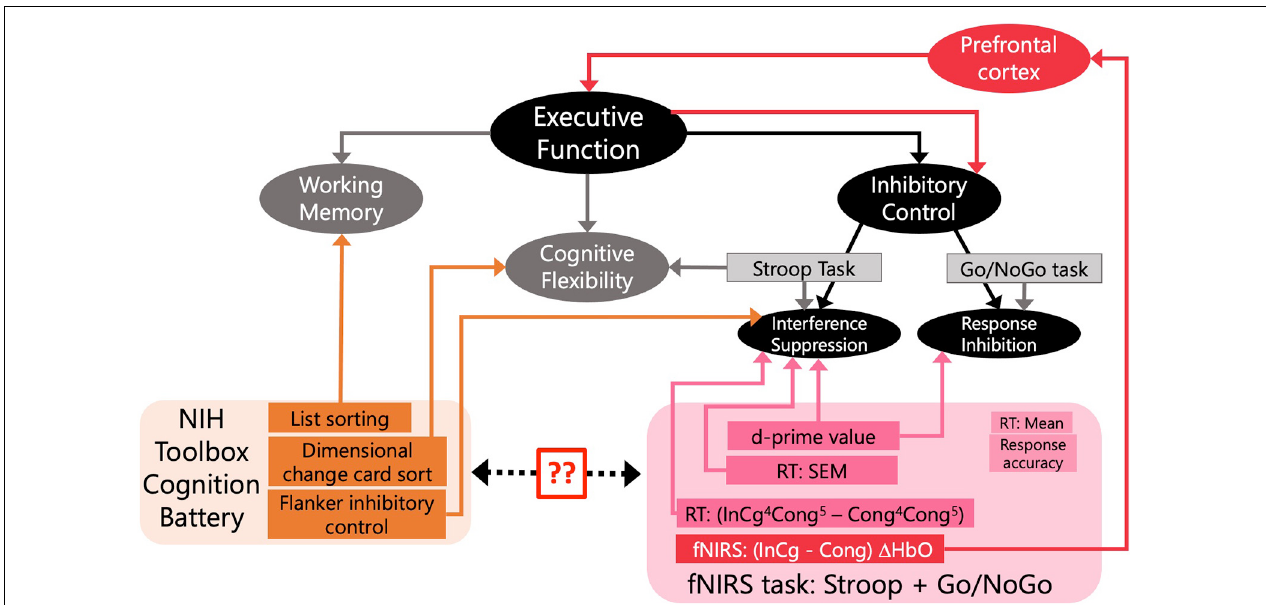
FIGURE 3 | Assessments of executive function (EF) involved in the current study. Rectangles represent assessments that were included to tap constructs of interest. The black and gray boxes reflect a conceptual model for EF and standard assessments for inhibitory control (IC). The orange rectangles are the behavioral assessments from the NIH Toolbox included in our study. The pink rectangles are measures from the designed fNIRS task. The two question marks note our first goal to validate the designed fNIRS task by comparing the behavioral measures in the fNIRS session with the standardized assessments from NIH Toolbox. The red lines and arrows note our second goal to tie fNIRS measures (red rectangle) in the PFC (red box) to EF and IC. For measures from our designed task, (InCg 4 Cong 5 -Cong 4 Cong 5 ) RT is the normalized difference in reaction times (RTs) between following ‘NoGo’ and ‘Go’ events; RT (SEM) is the standard error of mean for overall RTs; and d-prime is the sensitivity in distinguishing ‘NoGo’ from ‘Go’ events. The mean RT and response accuracy, though included here, were not used to reflect constructs measured as part of EF. For fNIRS responses (red rectangle), differences in the (cid:49) HbO amplitudes between the incongruent and congruent conditions were of interest to examine EF.